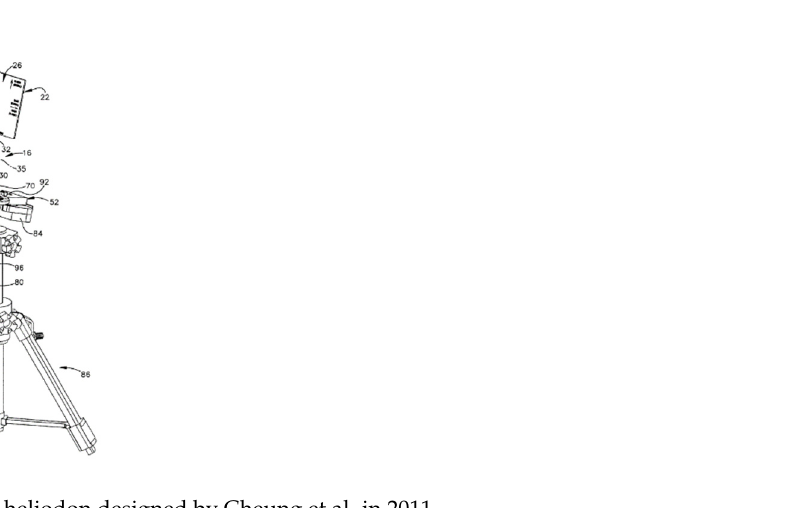
Figure 10. Patented heliodon designed by Cheung et al. in 2011.